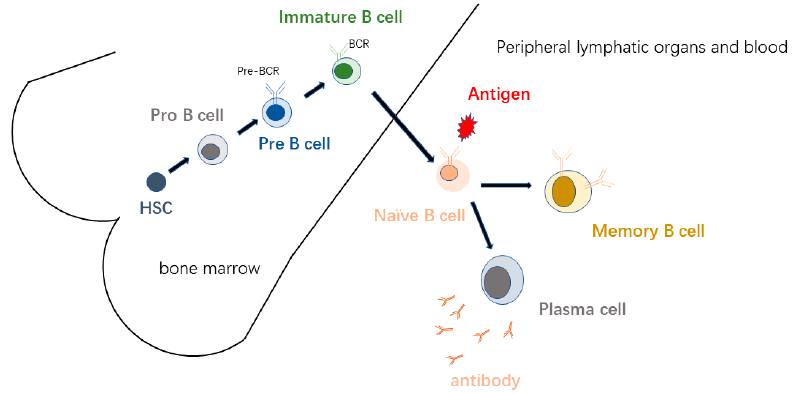
Figure 1. The development of B cells. B-cells develop in the bone marrow (BM) and later mature in the secondary lymphoid organs.